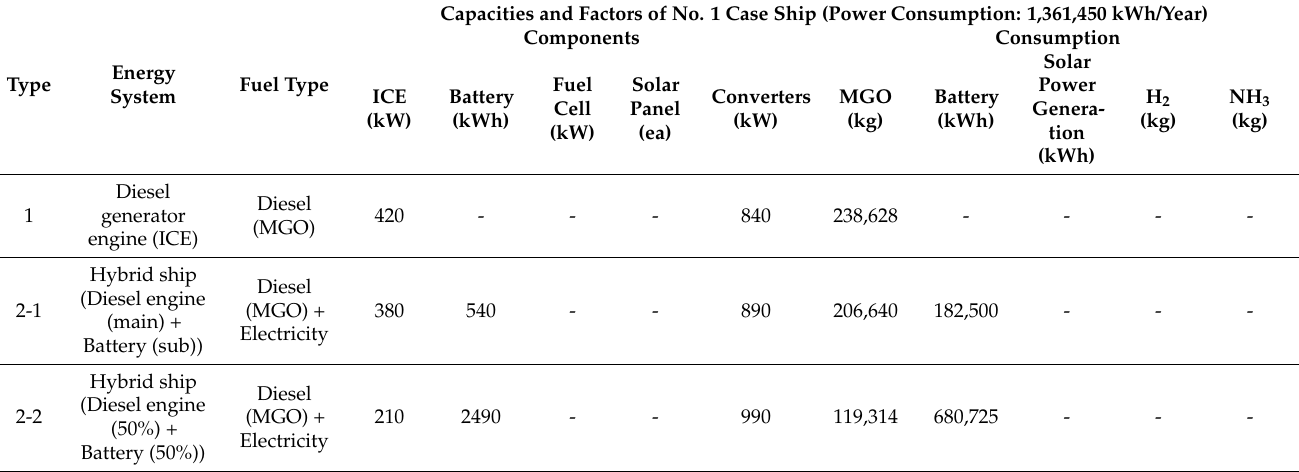
Table A1. Energy system scenario for ship propulsion and capacities and factors of No. 1 case